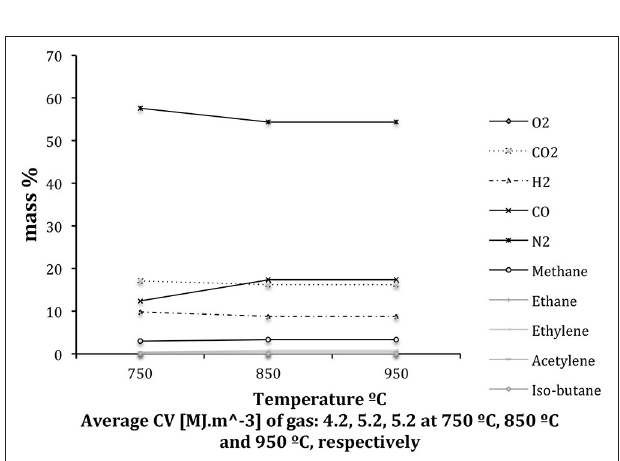
FIGURE 6 | Average gas compositions at the three temperature regions studied.